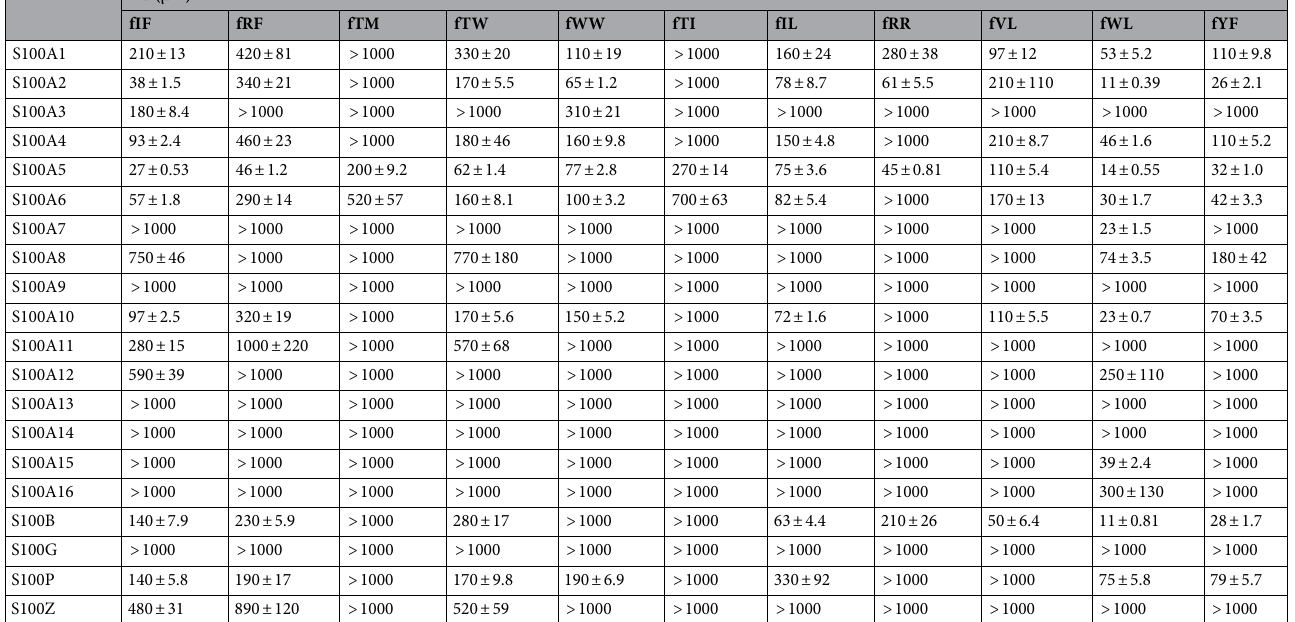
Table 1. The dissociation constants given as mean ± SEM of the selected foldamers and the S100ome measured by direct fluorescence polarization.